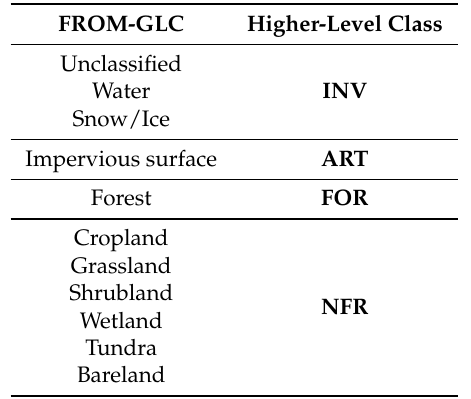
Figure 3. Finer Resolution Observation and Monitoring of Global Land Cover (FROM-GLC, 2017) reference map chosen for the training and validation stages. Black: invalid pixels (INV), blue: artificial surfaces (ART), green: forests (FOR), red: non-forested areas (NFR). The white numbers identify the corresponding stack, described in Table 2, while the numbers at the bottom show the orbits associated to the different swaths. Table 3. Finer Resolution Observation and Monitoring of Global Land Cover (FROM-GLC) classes aggregation strategy: artificial surfaces (ART), forests (FOR), non-forested areas (NFR), and water bodies and unclassified or no data as invalids